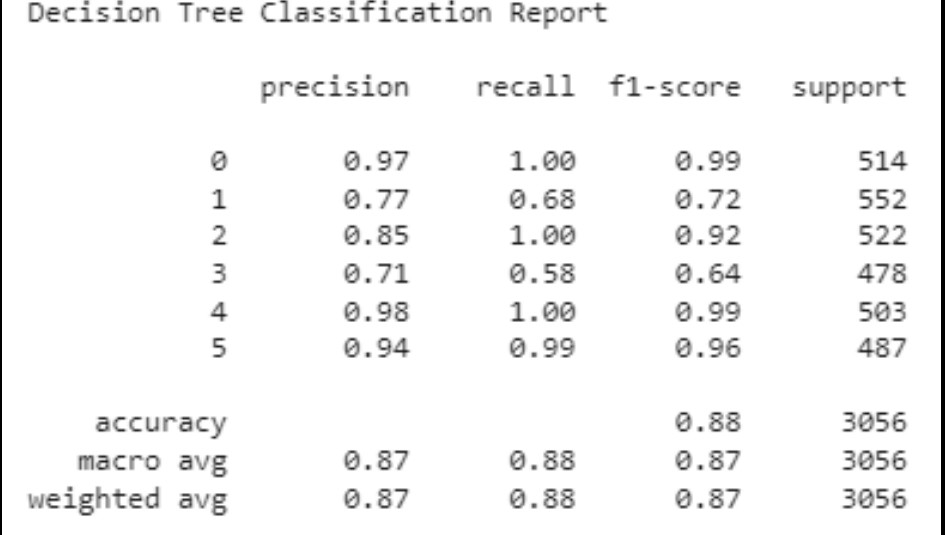
Figure 18. Classification Report of the decision tree.